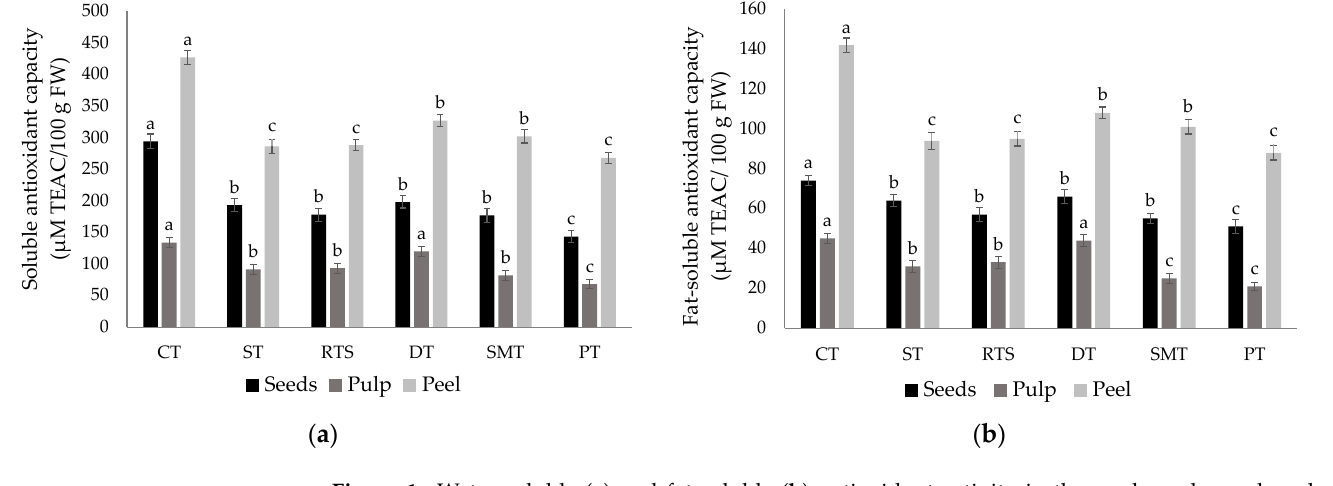
Figure 1. Water-soluble ( a ) and fat-soluble ( b ) antioxidant activity in the seeds, pulp, and peel fractions of each tomato cultivar: Cherry tomato (CT), Smooth round tomato (ST), Round tomato sauce (RTS), Datterino tomato (DT), S. Marzano tomato (SMT), and Piccadilly tomato (PT). The histograms represent mean ± SD. Results were analysed by one-way analysis of variance (ANOVA) followed by Holm-Sidak’s multiple comparisons test. Different letters indicate significant differences within each fraction among di ff erent tomato cultivars ( p < 0.001).